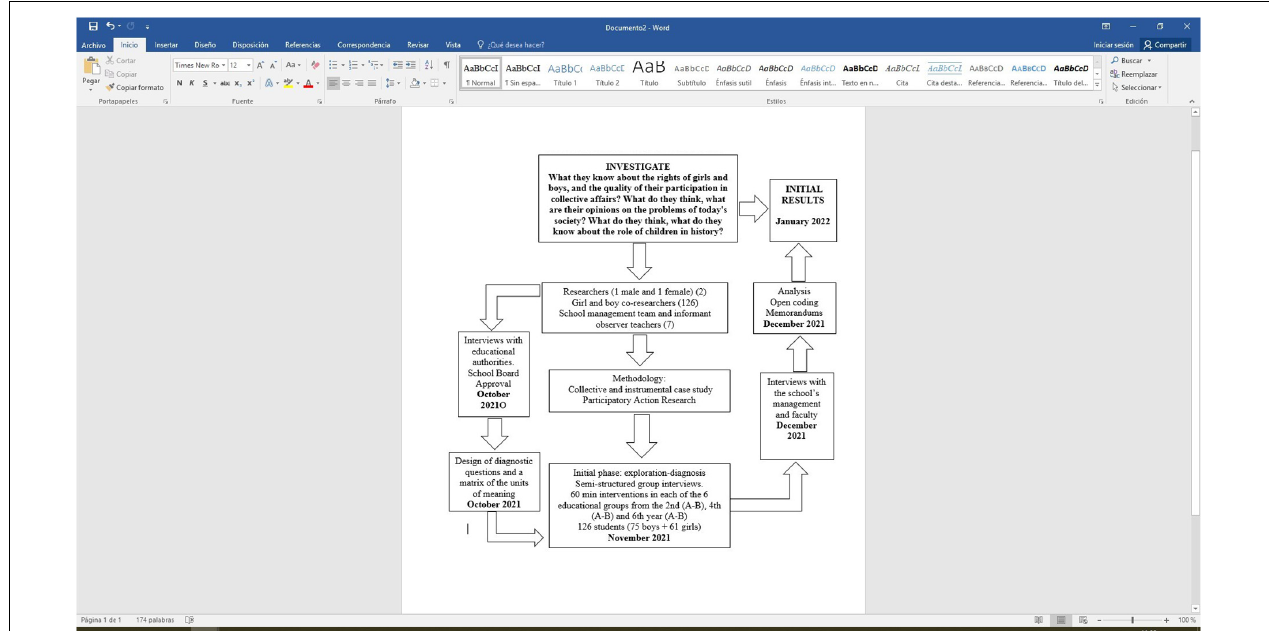
FIGURE 1 | Chronological scheme of the process followed in this first phase of the research.